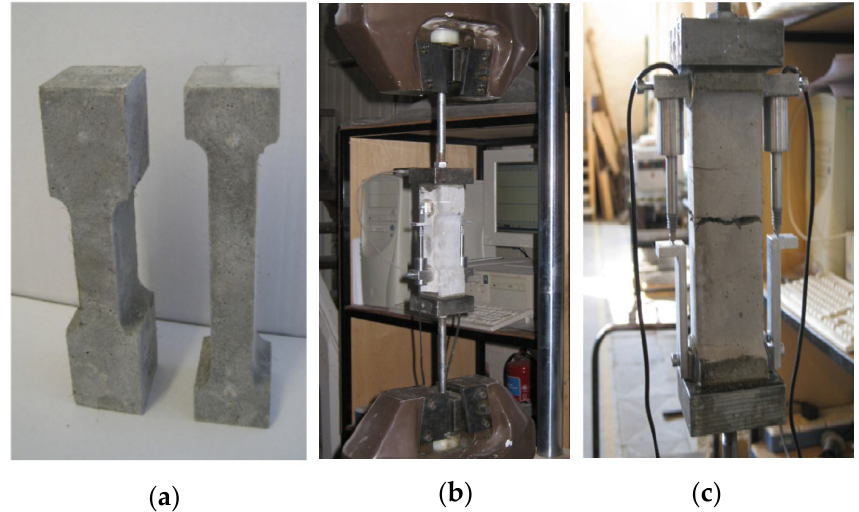
Figure 5. Evaluation of the direct tensile strength of UHPFRC: ( a ) Dog-bone specimens, ( b ) uniaxial tensile test set-up and ( c ) failure of the specimen ([30]–Elsevier Copyright).